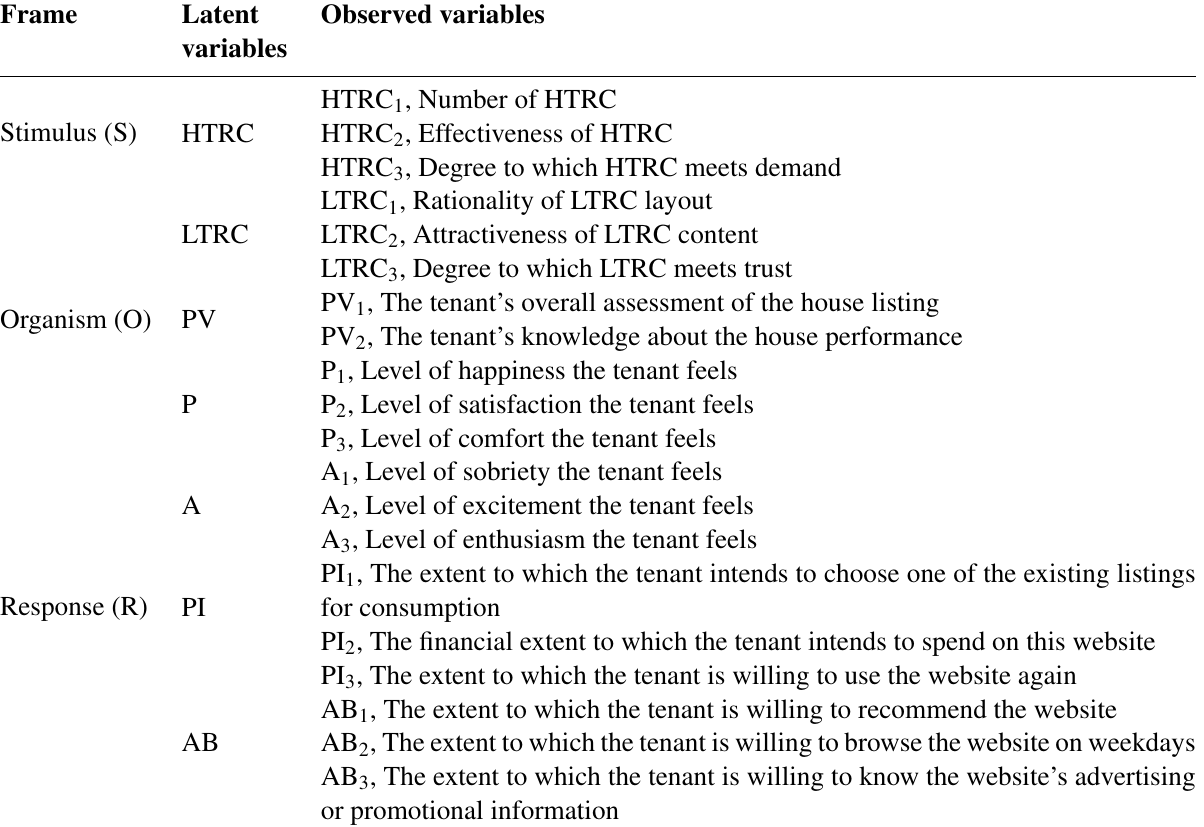
Table 1 Latent variables and their corresponding observation